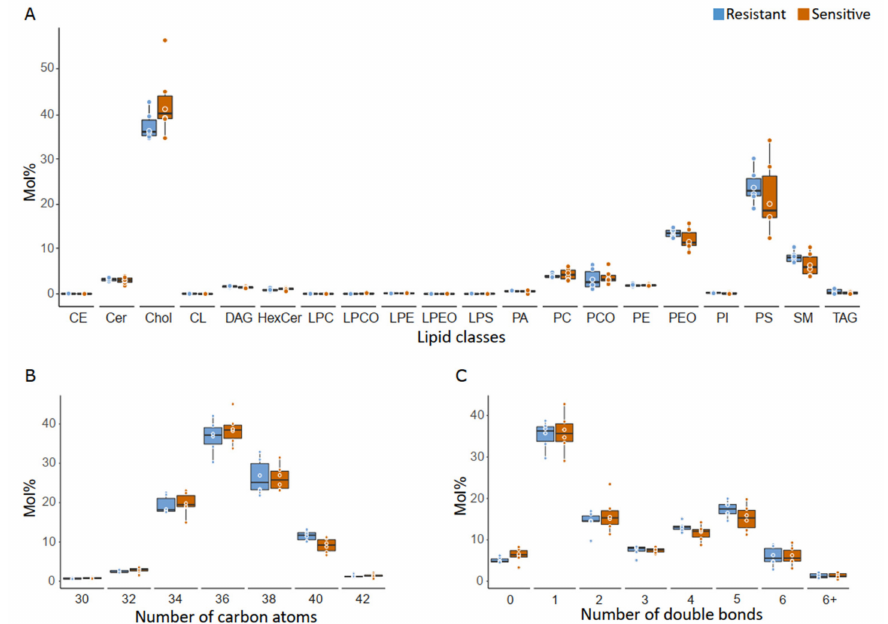
Figure 8. Lipid classes detected in seminal plasma, and profiles of total acyl chain length and unsaturation of nonstorage lipids. The mol% amounts of the di ff erent lipid features are presented as boxplots with dots. Each dot indicates a sample ( n = 6 in each group). Values did not di ff er between sensitive and resistant samples ( p > 0.05). ( A ) Lipid class composition. Mol% abundance of lipid classes in seminal plasma samples collected from ejaculates with resistant (blue bars) and sensitive (orange bars) sperm to 10% ( v / v ) autologous seminal plasma in extended semen at 144 h of storage. Prevalent lipid classes are cholesterol (Chol) and phosphatydilserine (PS). Classes appear in alphabetical order. The mole percent was calculated for all lipids. ( B ) Total acyl chain length profile. Lipids were regrouped according to the number of carbon atoms present in their acyl chains. The mole percent was calculated for sphingolipids, glycerophospholipids and diacylglycerides. Only length groups with a mean > 1 mol l% are shown. Shorter chain lipids (lipids with 32 carbon atoms) are lowly abundant, as well as very long lipids (42 carbon atoms). The most represented group consists of lipids with 36 carbon atoms. ( C ) Unsaturation profile. Lipids were regrouped according to the number of double bonds present in their acyl chains. All species with more than six double bonds are indicated with “6 + ”. The mole percent was calculated for sphingolipids, glycerophospholipids and diacylglycerides. 0 = saturated lipids; 1 = mono-unsaturated lipids; 2 = di-unsaturated lipids; 3–6 + = poly-unsaturated lipids. Boar seminal plasma contains many mono-unsaturated phospho- and